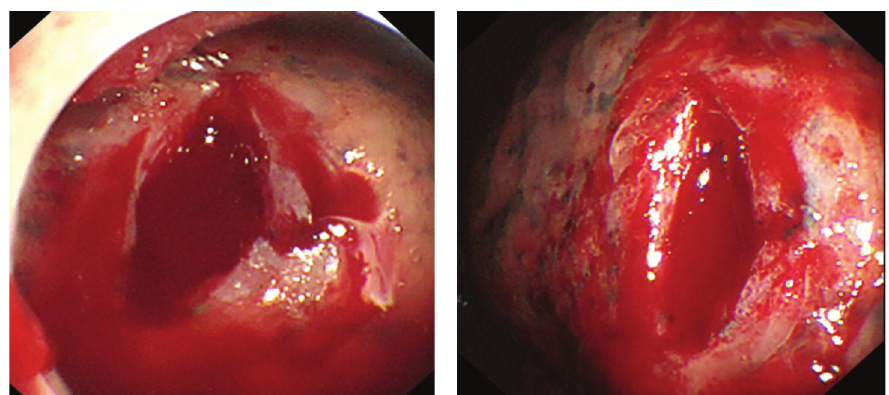
Figure 1: Lung laceration in one of the patients following introducing the